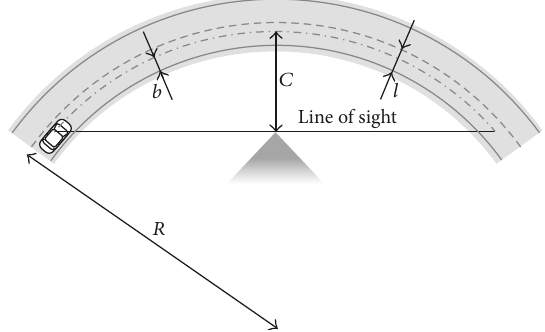
Figure 1: 2D modelling of ASD on horizontal curves longer than